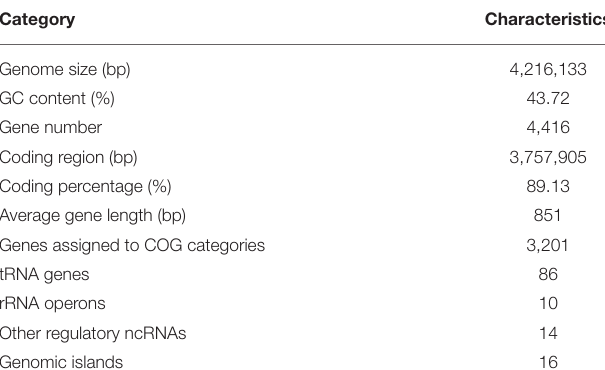
TABLE 1 | General features of Bacillus subtilis subsp. subtilis G7.